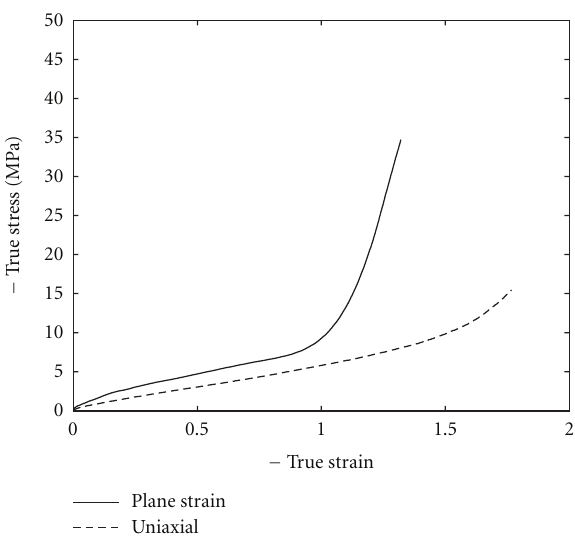
Figure 7: Strain state comparison, PET00, and 90 ◦ C and